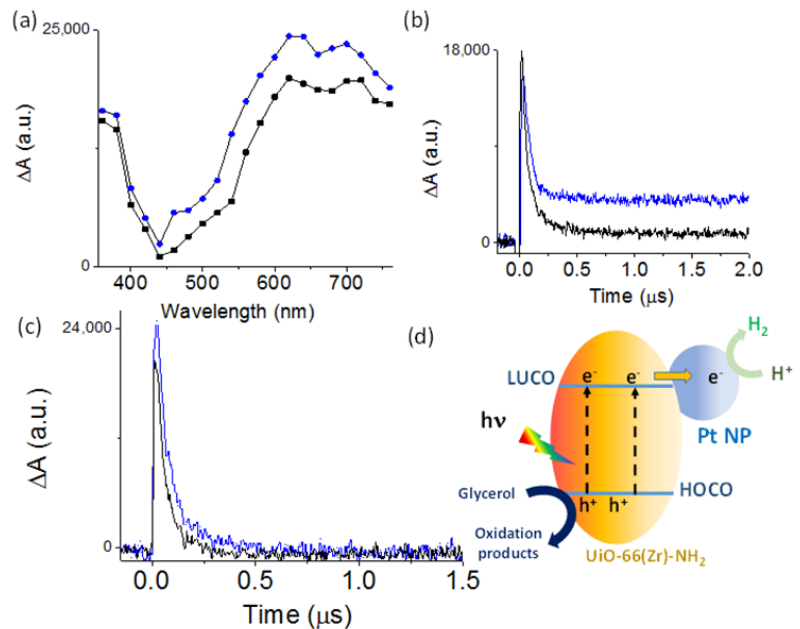
Figure 11. ( a ) Transient absorption spectra for UiO-66(Zr)-NH 2 (●) and Pt@UiO -66-NH 2 ( ■ ) upon excitation at 365 nm under Ar atmosphere recorded at 25 ns. Transient absorption decay kinetics for UiO-66(Zr)-NH 2 (blue line) and Pt@UiO-66(Zr)-NH 2 (black line) recorded at 380 ( b ) or 680 ( c ) nm under Ar. ( d ) Simplified illustration of the proposed reaction mechanism using Pt@UiO-66(Zr)-NH 2 . Aiming to bring light to the nature of the observed photoinduced charge separation species for the most active Pt@UiO-66(Zr)-NH 2 sample, additional TAS measurements